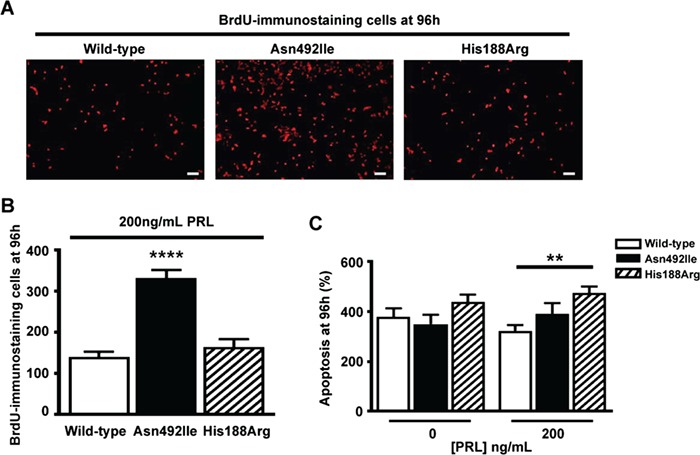
Effects of the Asn492Ile PRLR variant and His188Arg mutant on proliferation, assessed by BrdU incorporation, and on apoptosis, assessed by Caspase-3/7 assays. (A) Representative images showing BrdU-immunostaining in HEK293 cells that were transfected with WT, variant Asn492Ile or mutant His188Arg PRLR. Following transfection, the HEK293 cells were exposed to 200 ng/mL PRL, and at 96 h incubated with BrdU for 15 min to assess the number of proliferating cells. Bar indicates 20 μm. (B) Quantification of the number of BrdU-immunostained cells. Cells transfected with the Asn492Ile PRLR variant showed significantly increased BrdU immunostaining, when compared to cells transfected with WT PRLR or the mutant His188Arg PRLR, thereby confirming that the Asn492Ile PRLR variant is associated with increased proliferation (Fig. 5E). Mean ± SEM from N = 5 coverslips per construct, with four images taken per coverslip. Coverslips were prepared from independent transfections that were performed on two separate days. ****P < 0.0001. (C) Quantification of Caspase-3/7-mediated apoptosis activity in transfected HEK293 cells. Cells were transfected with WT, variant Asn492Ile or mutant His188Arg, treated with 0 ng/mL PRL or 200 ng/mL PRL and assessed for apoptosis at 96 h. Data were normalized to the number of proliferating cells at hour 0. Following treatment with PRL, cells expressing the His188Arg PRLR mutant had significantly more apoptosis than WT cells or cells expressing the Asn492Ile variant. Mean ± SEM for four apoptosis assays with each assay performed with four technical replicates. **P < 0.01.